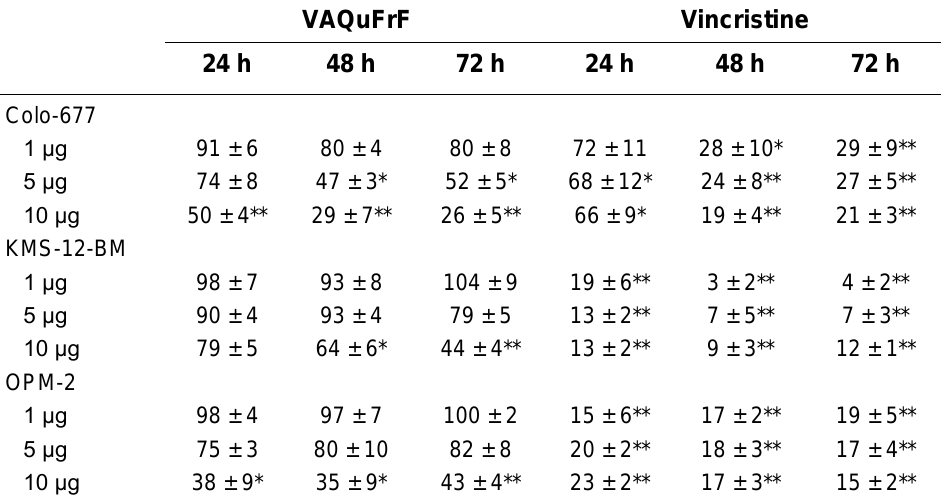
The cells were incubated for 24, 48, and 72 h with VAQuFrF or vincristine (1, 5, and 10 μg/10 5 cells). The proliferation of untreated cells was taken as 100%. The values (in %) are the mean ± SEM of three to five independent experiments. * p < 0.05; ** p < 0.01 vs. controls.